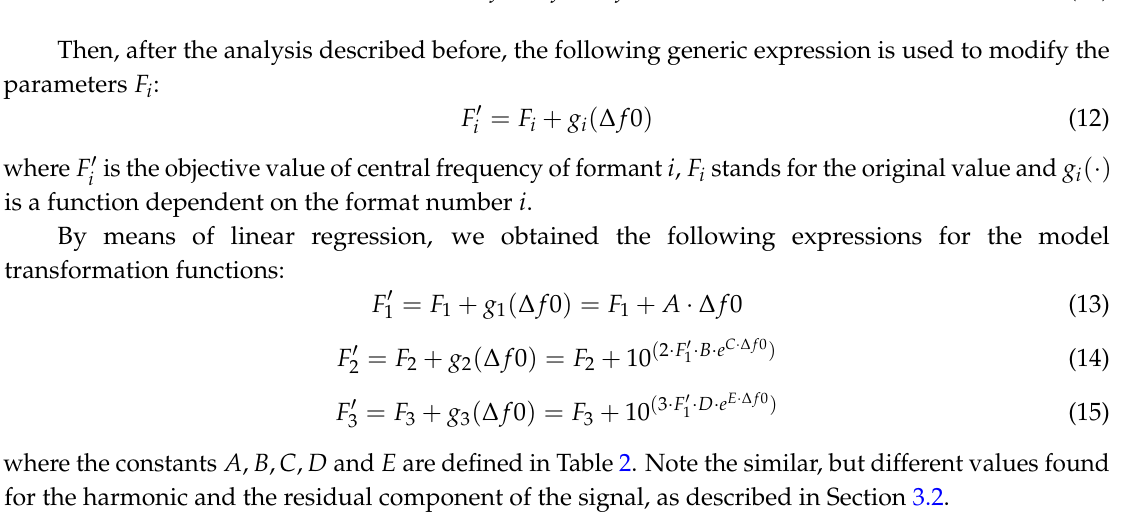
Table 2. Parameters involved in the expressions F (cid:48)